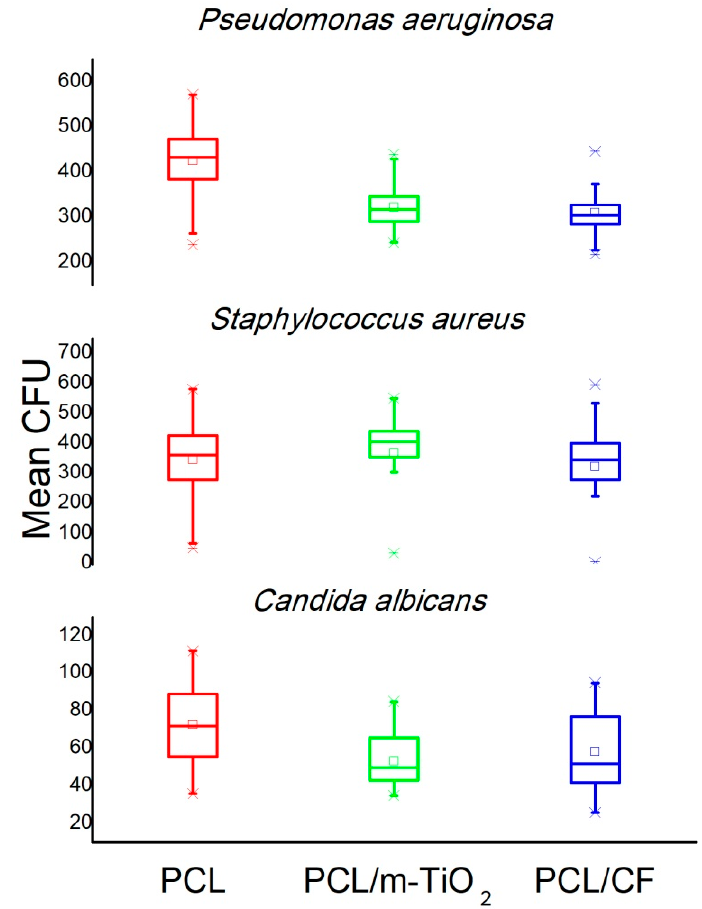
Figure 12. Antimicrobial efficacy of the electrospun PCL, PCL/m-TiO 2 and PCL/5 wt % CF scaffolds against Pseudomonas aeruginosa , Staphylococcus aureus and Candida albicans.